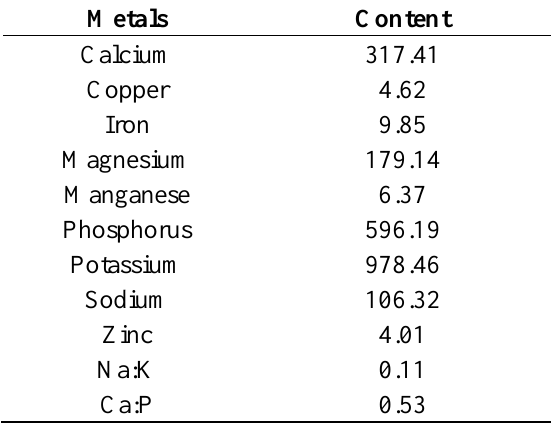
Table 4. Mineral content (mg/100 g) of I. hederacea seeds.